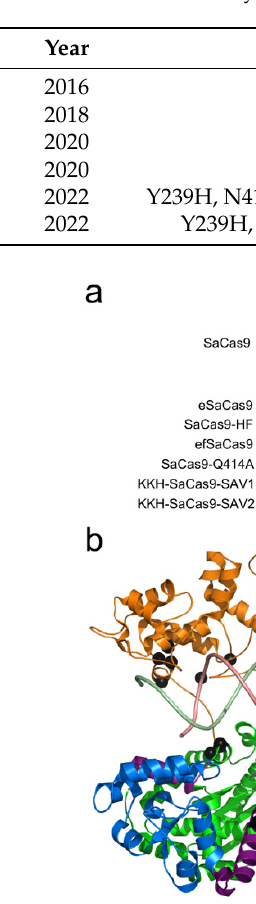
Table 3. Summary of SaCas9 variants for improving editing specificity.